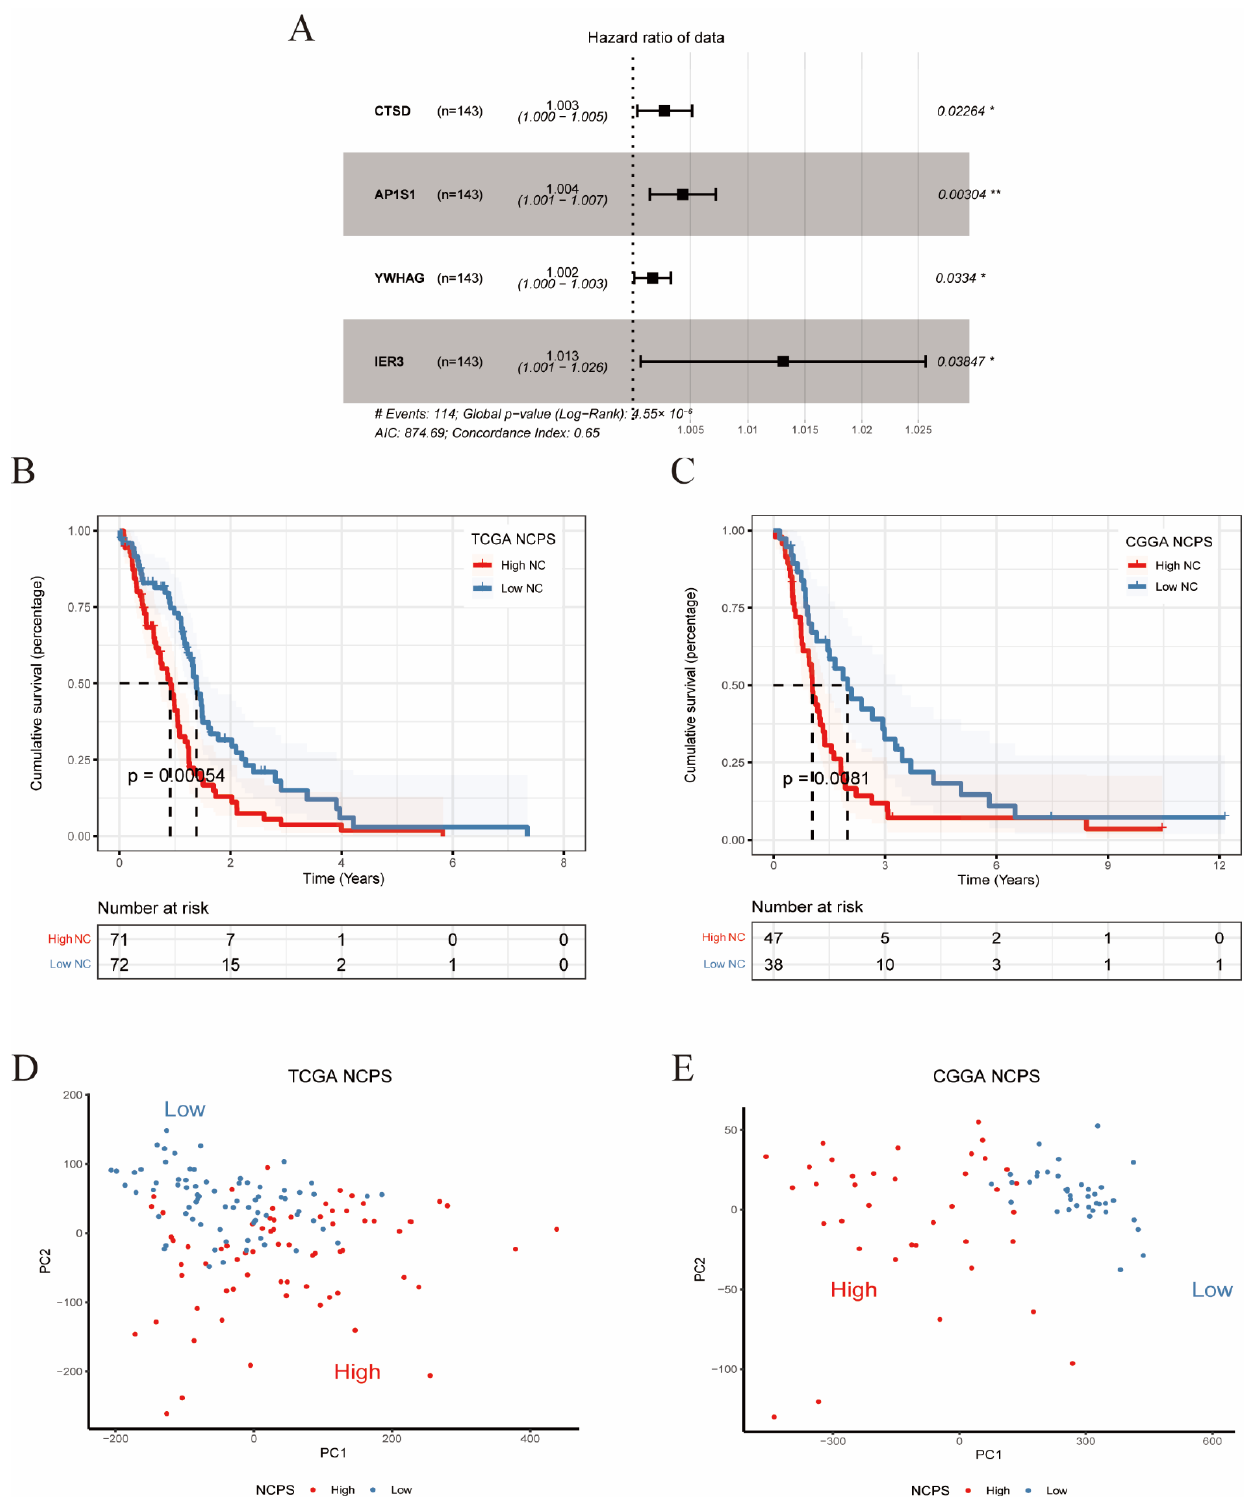
Figure 4. Multivariate Cox and survival analysis. ( A ) Hazard ratio and p -value of constituents involved in multivariate Cox regression and some parameters of the signature. ( B ) Survival analysis of TCGA cohort. The prognosis was significantly worse in the high-NCPS group ( p < 0.001). ( C ) Survival analysis of CGGA cohort. The prognosis was significantly worse in the high-NCPS group ( p < 0.01). ( D , E ) PCA analysis in TCGA cohort and CGGA cohort. It was found that the model could group GBM patients well in both the training cohort and the validation cohort. * p < 0.05; ** p < 0.01